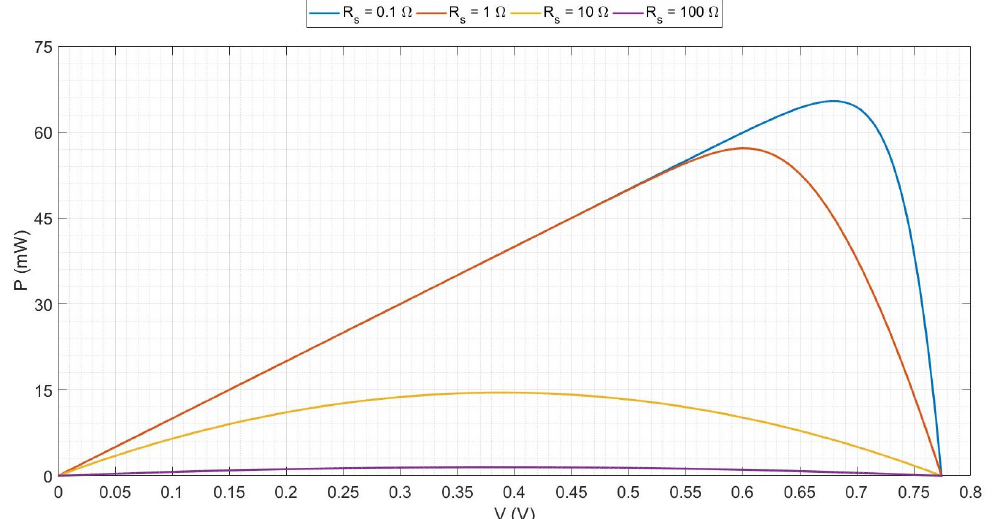
Figure 11. Example of P(V) curves for different values of R s : the effect of the series resistance on the power–voltage